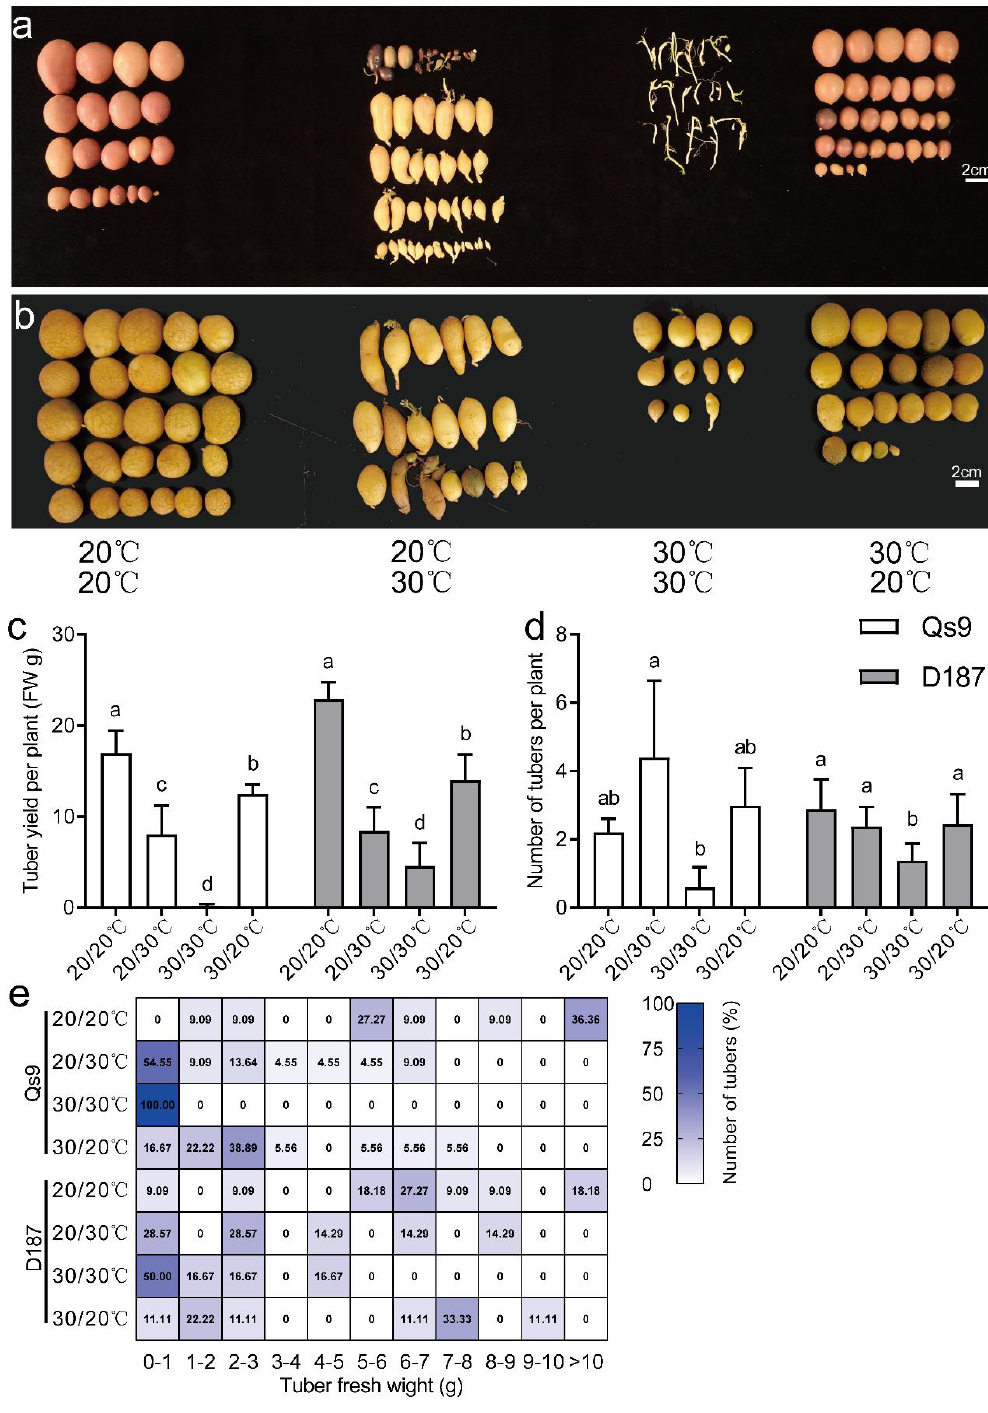
Figure 5. Phenotypes and tuber productivity of the Qs9 and D187 plants under the heat-stress treatment of different plant parts. ( a , b ): Photographs of the total tubers harvested from the nine plants. a : Qs9, b : D187. ( c , d ): Measurement of tuber productivity under the heat-stress treatments of different parts of the plants. Tuber yield ( c ) and tuber number ( d ) per plant; nine replicates were averaged and statistically analysed. The different lowercase letters indicate groups that are significantly different from one another. ( e ) The percentage of tuber numbers among the total number of tubers in the annotated range of fresh weight is displayed using a heatmap. The total number of tubers is the sum of the tuber numbers in all analysed potato plants in each